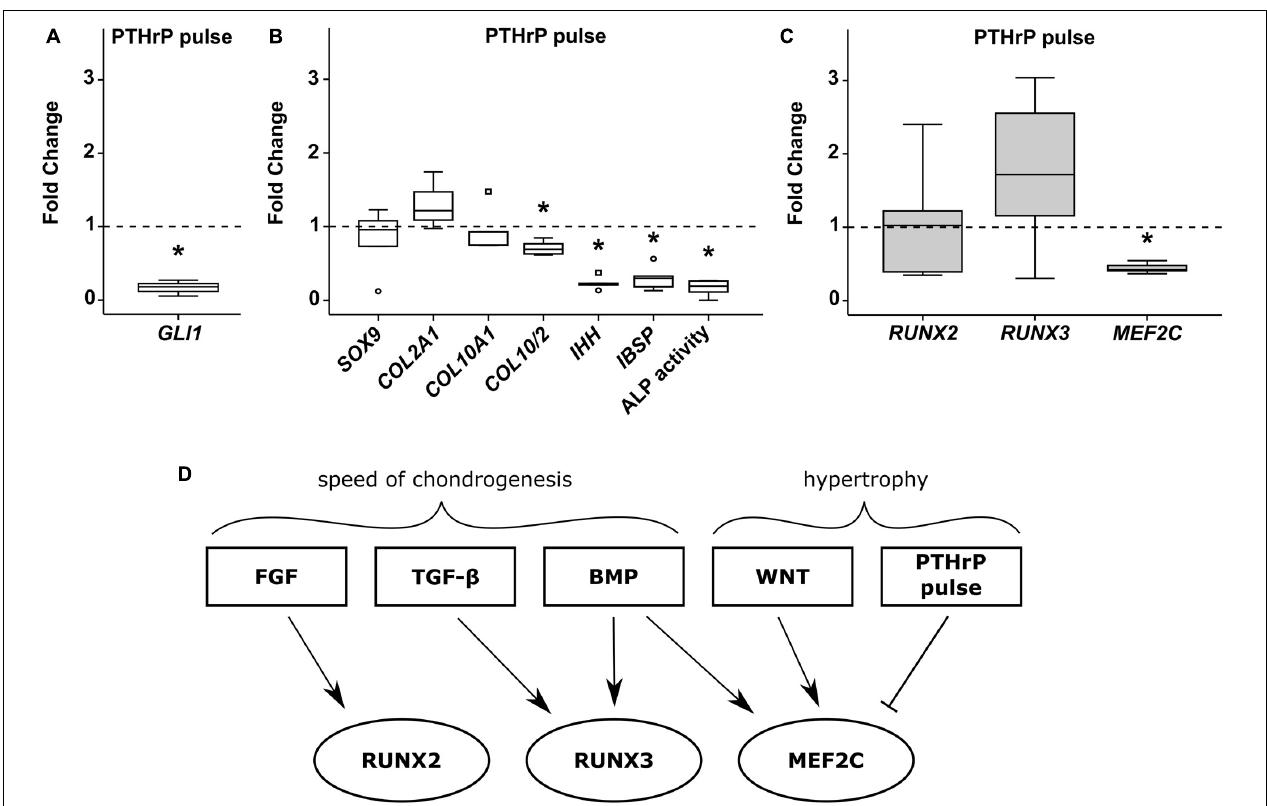
FIGURE 8 | Effects of pulsed PTHrP treatment on RUNX2, RUNX3 and MEF2C. MPC pellets were subjected to chondrogenic induction for 1 week before half of the pellets were stimulated with 2.5 nM PTHrP(1-34) for 6 h daily while the others received daily medium exchange until week 6 ( n = 5 donors). Expression of indicated genes was determined by qPCR (A–C) , and levels were referred to reference genes HNRPH1 and CPSF6 . (A) Gene expression of the HH downstream target GLI1 ( n = 3). ALP activity was quantified in culture supernatants (B) . Expression levels of indicated genes and ALP activity are referred to DMSO cultures (dashed lines). Box plots were generated as described in Figure 1 , outliers are depicted as ◦ and extreme values as (cid:3) . *, p ≤ 0.05, Mann–Whitney U test compared to control. (D) Overview of pathways regulating RUNX2, RUNX3, and MEF2C during MPC